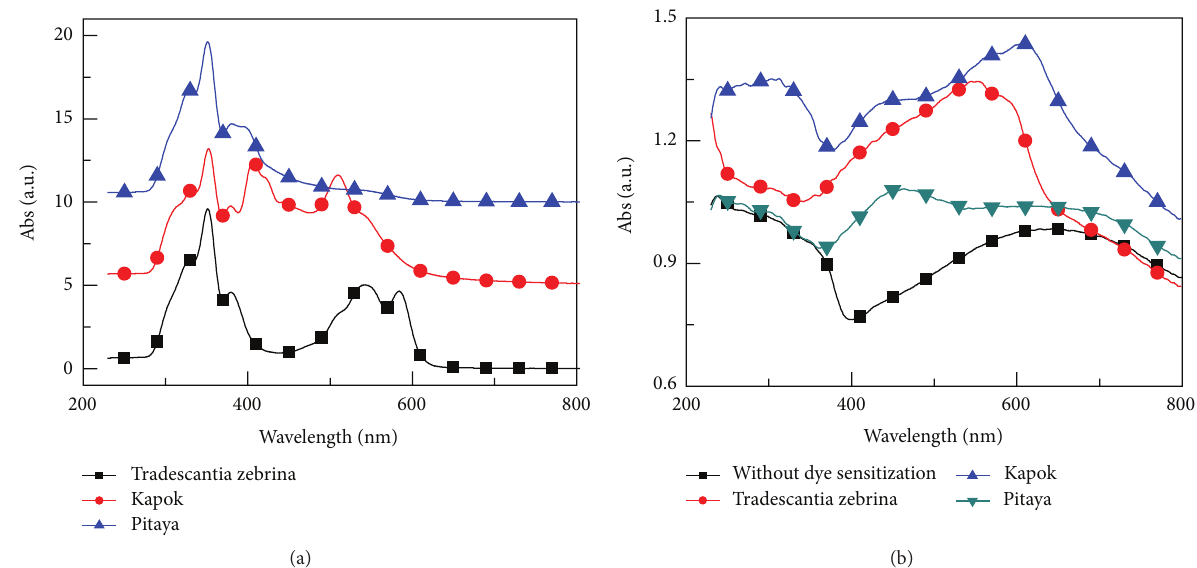
Figure 3: Comparison of the absorption spectra of the natural extracts: (a) in acid solution; (b) adsorbed on TiO 2 electrode.